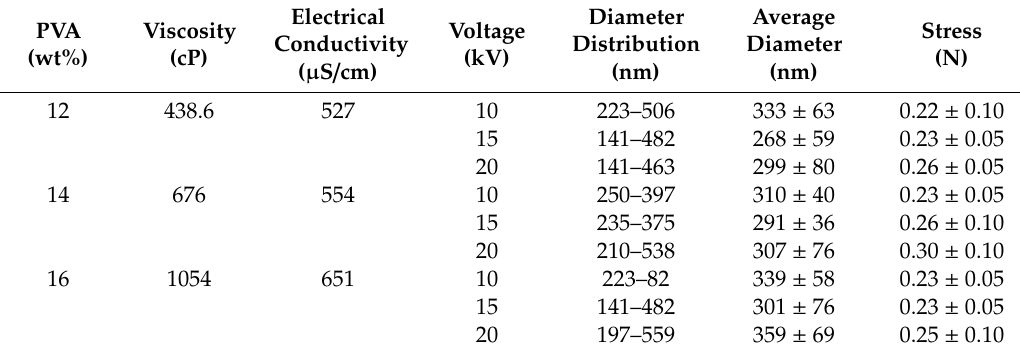
Table 1. Physical properties of polyvinyl alcohol (PVA) solutions and diameter distribution of PVA nanofibrous